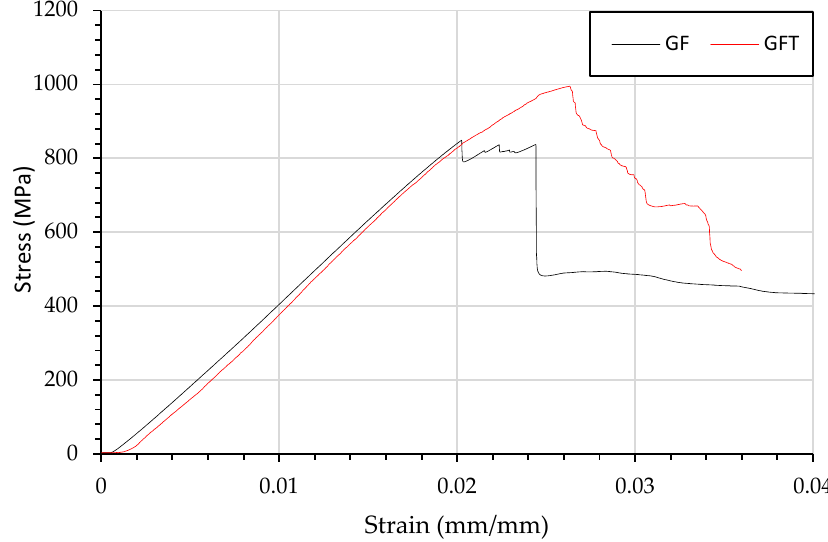
Figure 6. Flexural testing using three-point bending of composites beams and resulting stress strain curve of GF and GFT.